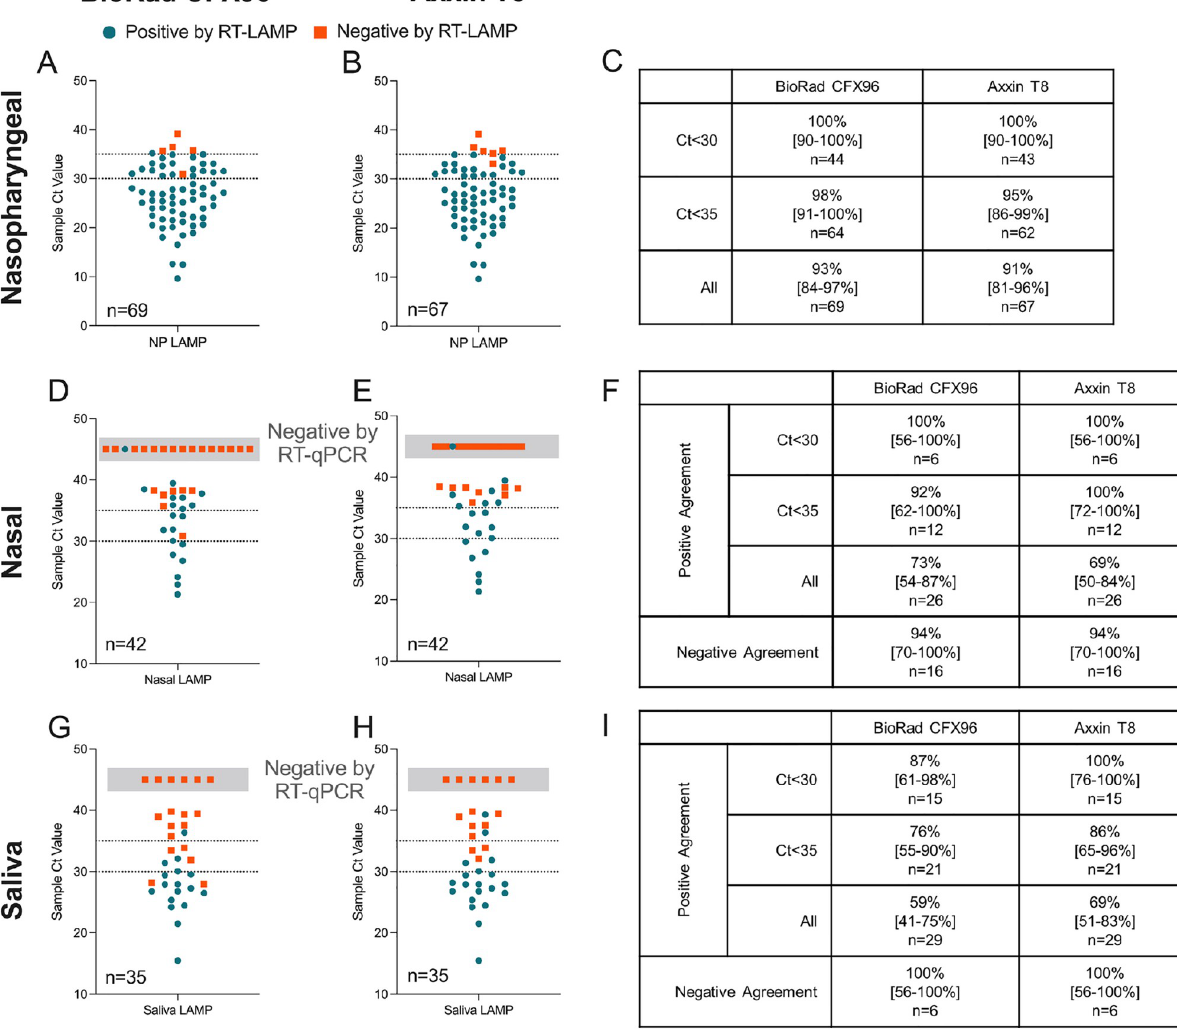
Fig 6. RT-LAMP performance on clinical samples. (A,B) Summary of RT-LAMP results for nasopharyngeal samples, stratified by the Ct value obtained in RT-qPCR. Nasopharyngeal samples were tested on (A) the Bio-Rad CFX96 and (B) the Axxin T8. (C) Positive agreement and 95% confidence intervals with RT-qPCR at varying Ct thresholds. (D,E) Summary of RT-LAMP results for nasal samples compared to the nasal sample Ct value obtained in RT-qPCR, when tested on (D) the Bio-Rad CFX96 and (E) the Axxin T8. (F) Positive and negative agreement with RT-qPCR and 95% confidence intervals for nasal samples. (G,H) Summary of RT-LAMP results for saliva samples compared to the saliva sample Ct value obtained in RT- qPCR, when tested on (G) the Bio-Rad CFX96 and (H) the Axxin T8. (I) Positive and negative agreement with RT-qPCR and 95% confidence intervals for saliva